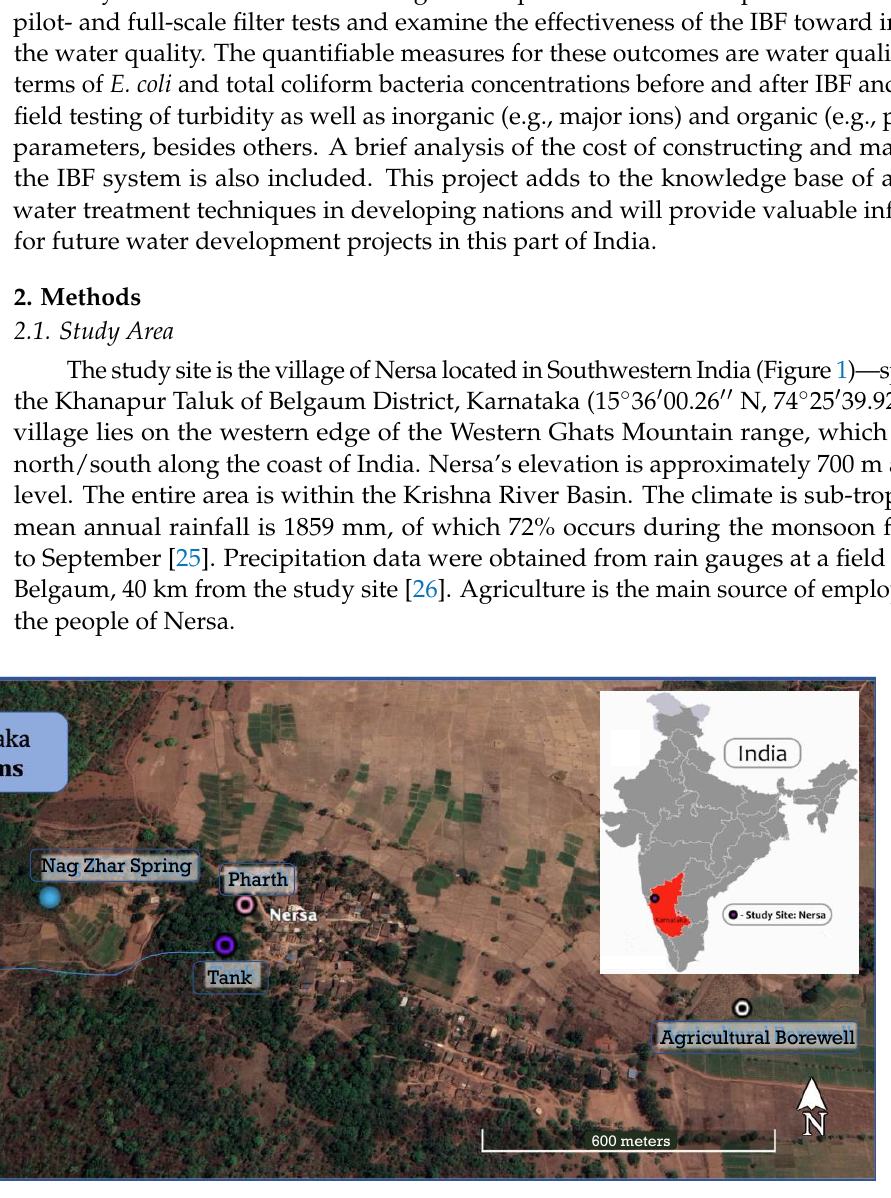
Figure 1. The study area is located in the Khanapur Taluk of Belgaum District, Karnataka in South- western